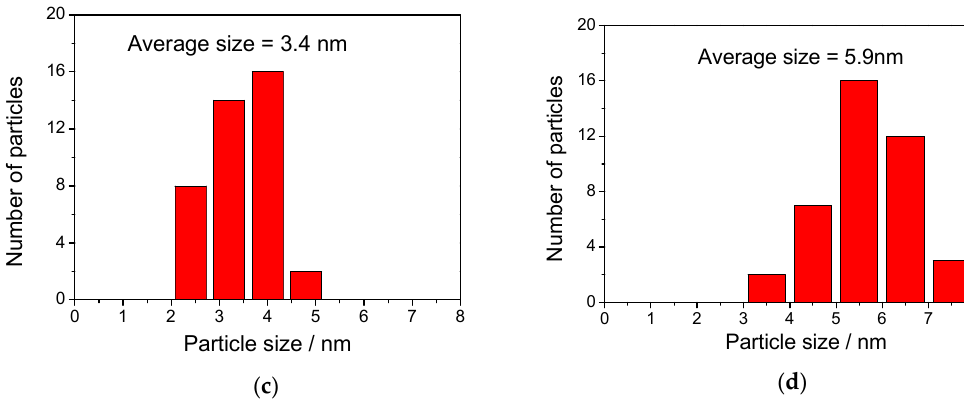
Figure 8. TEM images of ( a ) spent Pd/AC, and ( b ) spent Pd/N-AC, and Pd size distribution of ( c ) spent Pd/AC and ( d ) spent Pd/N-AC in the hydrodechlorination of R-115.